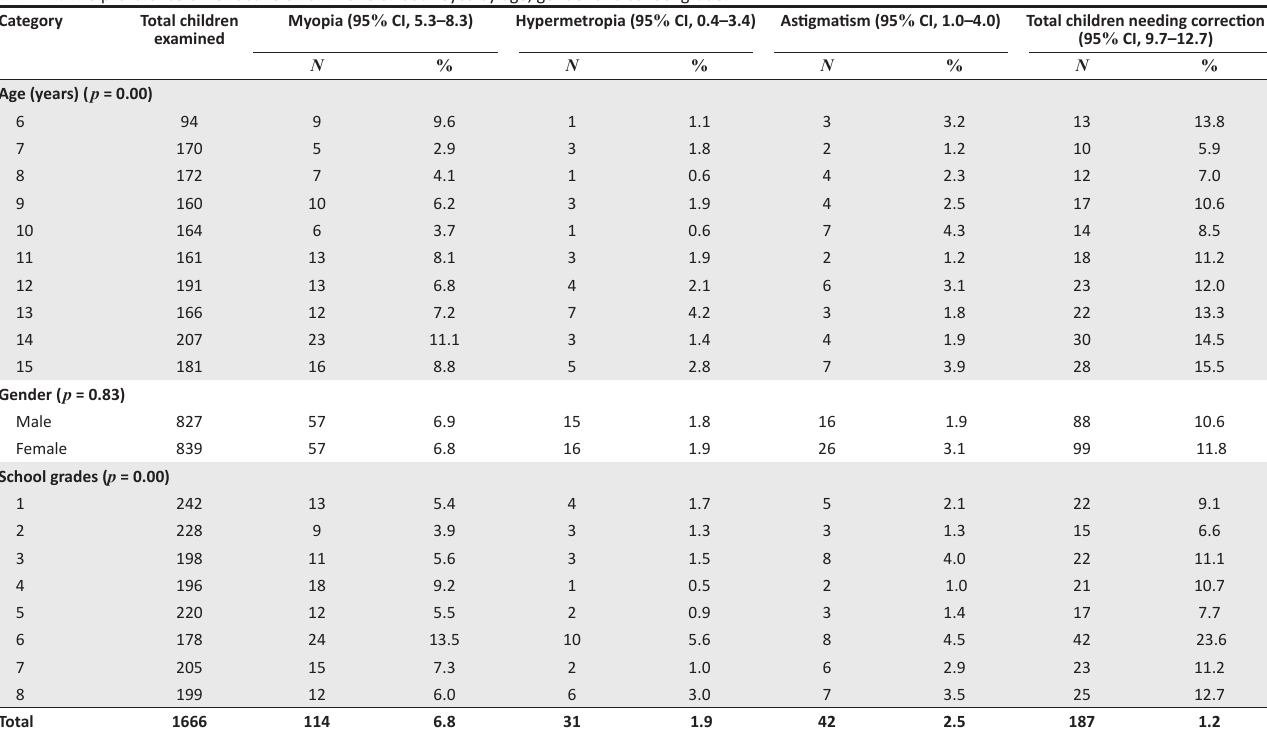
TABLE 4: The prevalence of refractive error in one or both eyes by age, gender and school grade. Category Total children